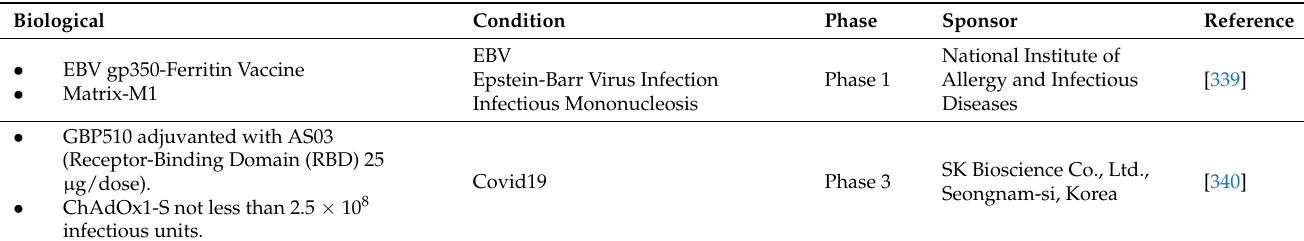
Table 6. Summary of active clinical trials for nanoparticle-based